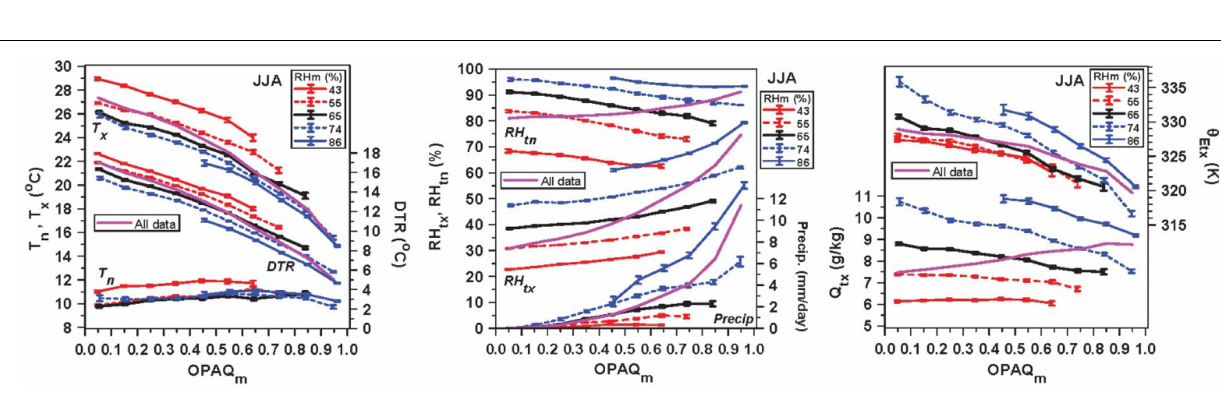
FIGURE 7 | BSRN ECA plotted against OPAQSW at Regina for warm and cold seasons with regression fits.